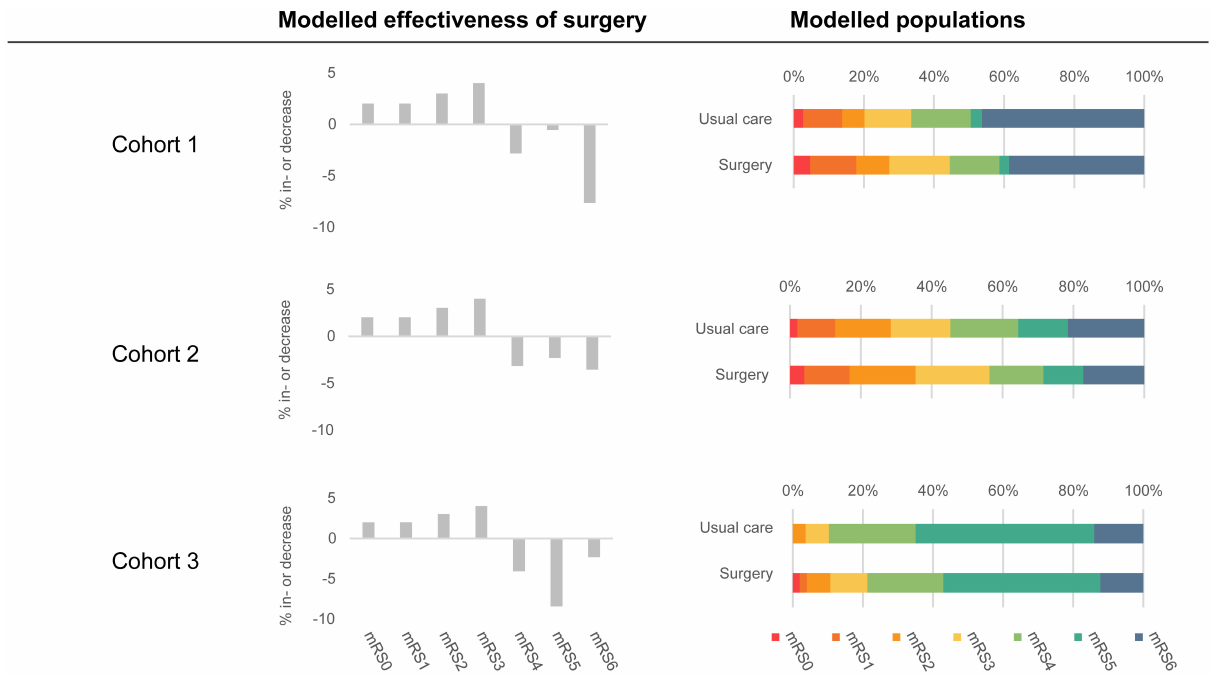
FIGURE 2 | An overview of included populations and modeled effectiveness of MIS. The modeled populations column shows the distributions of the patient populations in both strategies at 3 months post-ICH. The usual care strategy is based on the Hemphill (Cohort 1), TICH-2 (Cohort 2), and MISTIE-III (Cohort 3) populations. The surgery strategy is based on usual care strategy in combination with the modeled effectiveness of surgery (displayed in the middle of the figure). Modeled effectiveness of surgery was based on 11% effectiveness.